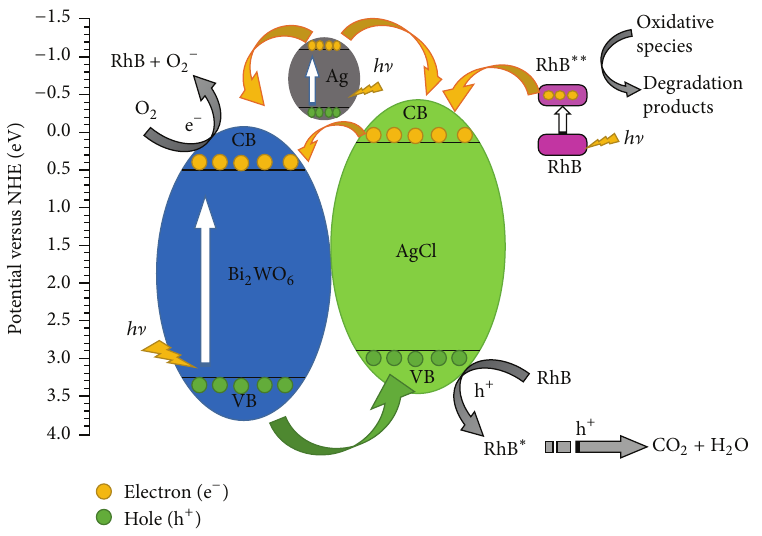
Figure 15: Schematic of possible mechanism of degrading RhB in the presence of Ag/AgCl-Bi 2 WO 6